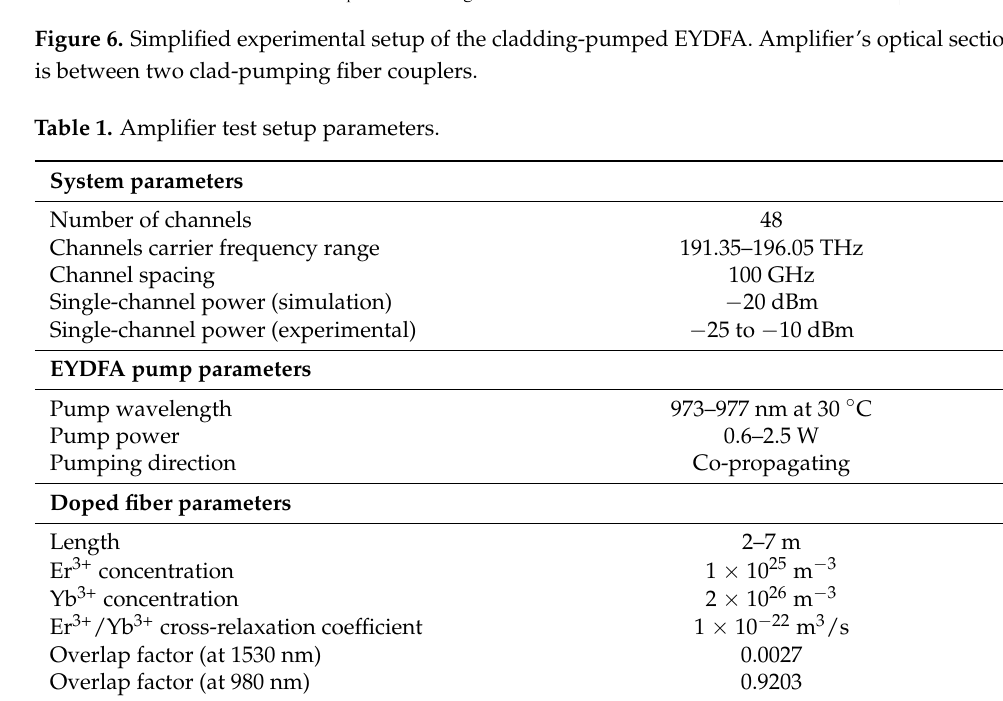
Table 1. Amplifier test setup parameters.